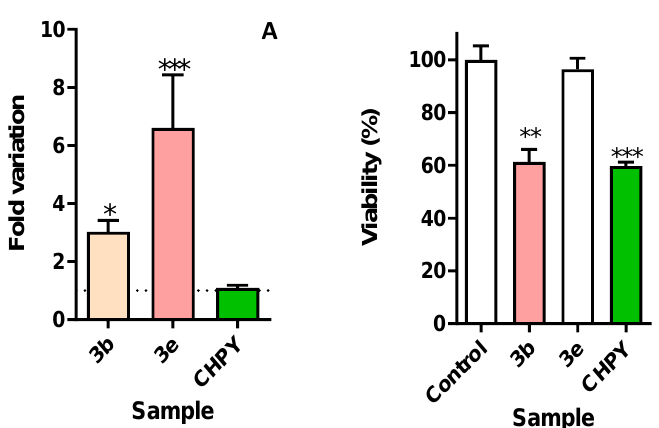
Figure 3. ( A ) Caspase-like activity found in Sf9 cells after incubation with compounds 3b (100 µ g / mL) and 3e (50 µ g / mL), or the reference insecticide chlorpyrifos (CHPY, 100 µ g / mL), for 24 h. ( B ) Viability of human keratinocytes exposed to compounds 3b and 3e (100 µ g / mL), medium (control), or the reference insecticide chlorpyrifos (CHPY, 100 µ g / mL). Cells were incubated for 24 h, after which viability was evaluated. * p < 0.05; ** p < 0.01; *** p < 0.001.